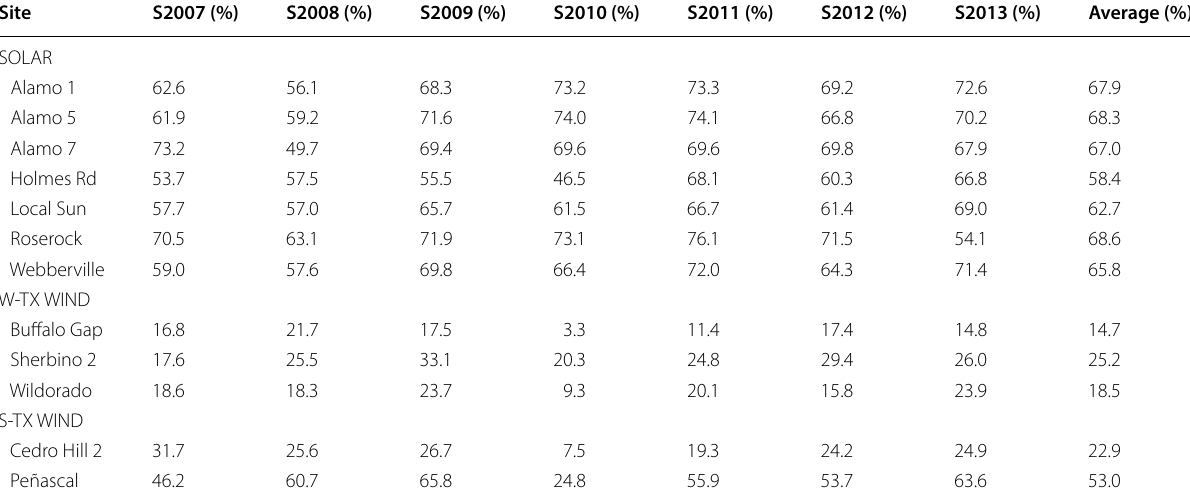
Table 1 Peak average capacity percentages for each solar and wind site during each summer Site